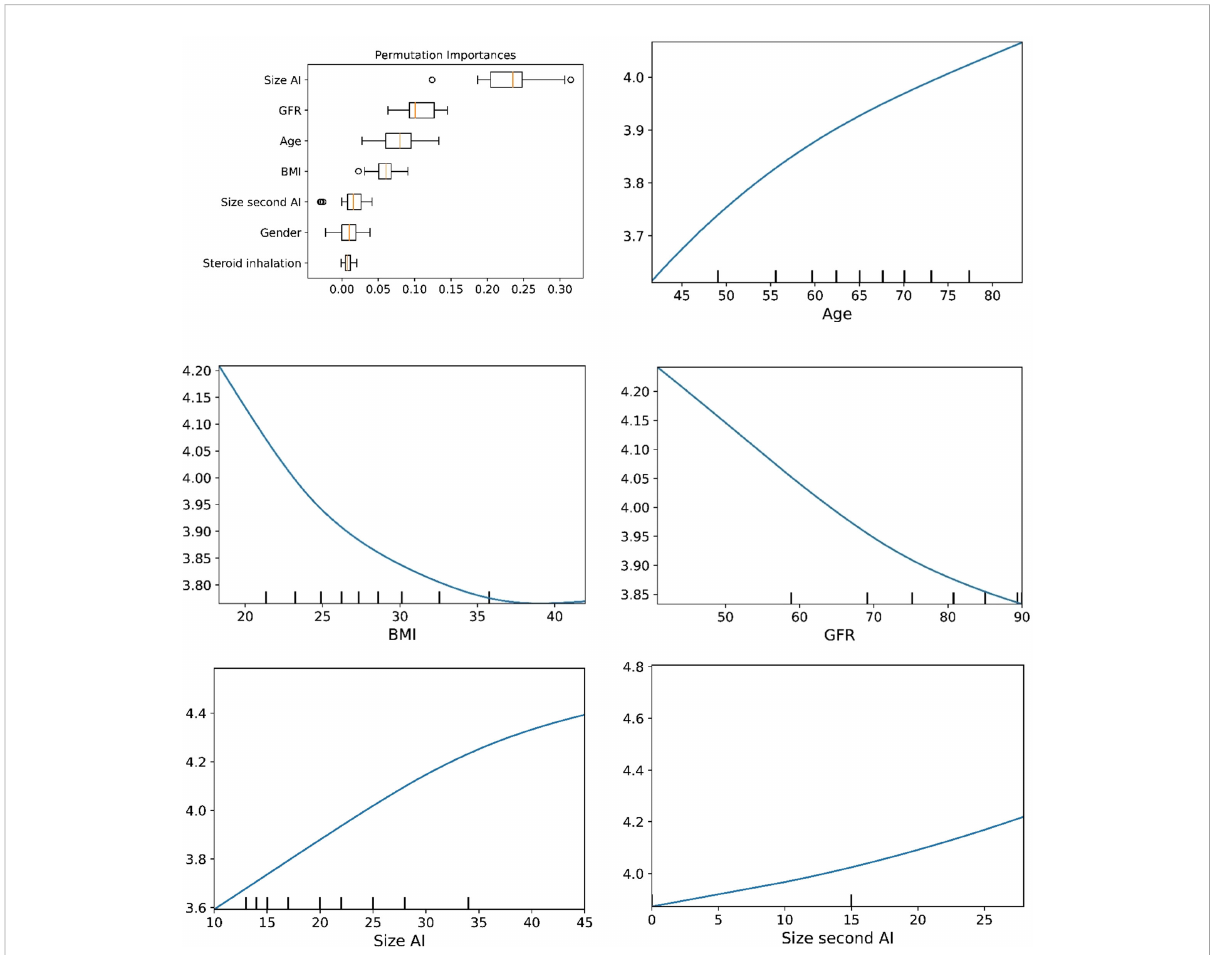
FIGURE 5 The plots for permutation importance and ln-transformed cortisol DST against age, BMI, eGFR, size of AI (in bilateral AI, the size of the largest AI), and size of the second AI using the ML model multilayer